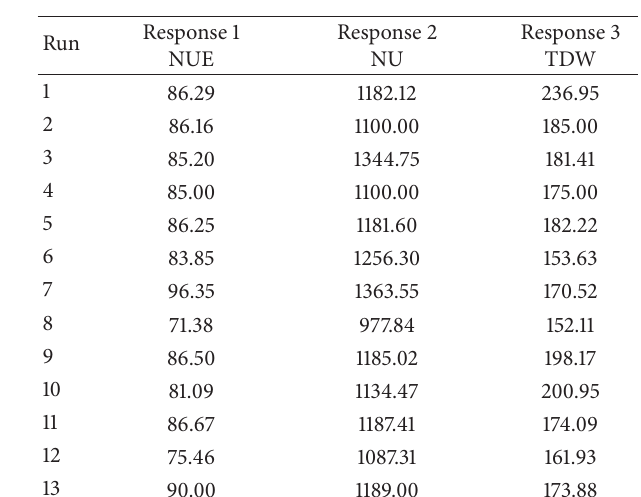
Table 3: Results of